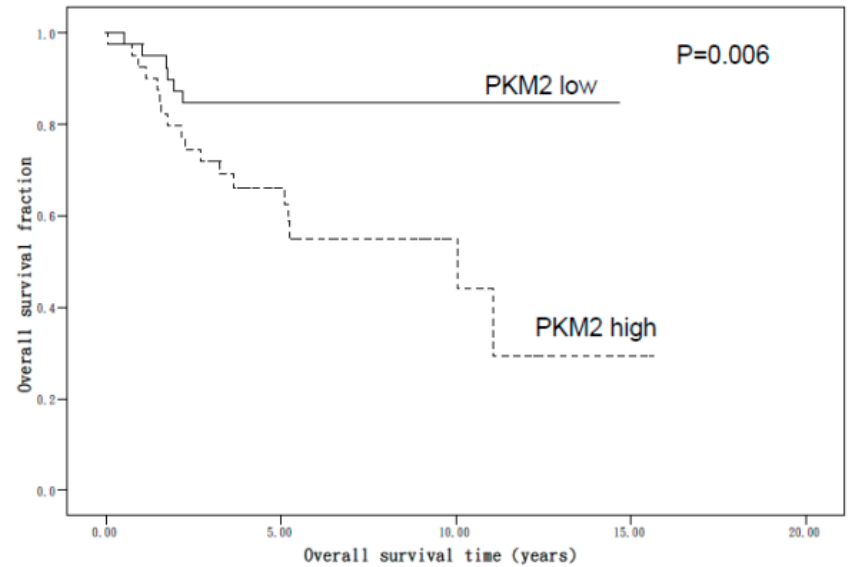
Figure 3. Kaplan–Meier analysis of survival in patients with endometrial carcinoma (EC) based on pyruvate kinase M2 (PKM2) protein immunostaining. Patients with a higher PKM2 score had a poor overall survival compared with those with a lower score in all patients with EC (p = 0.006).